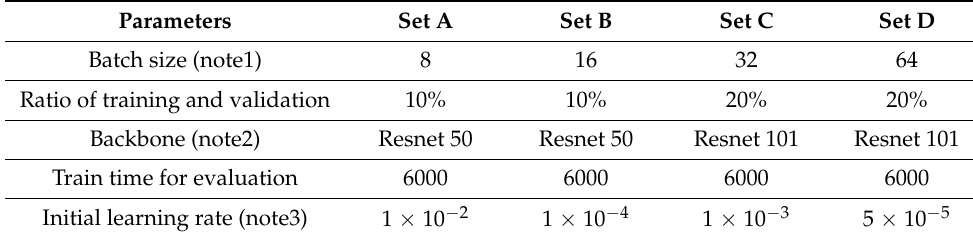
Table 3. Parameters for the model training.